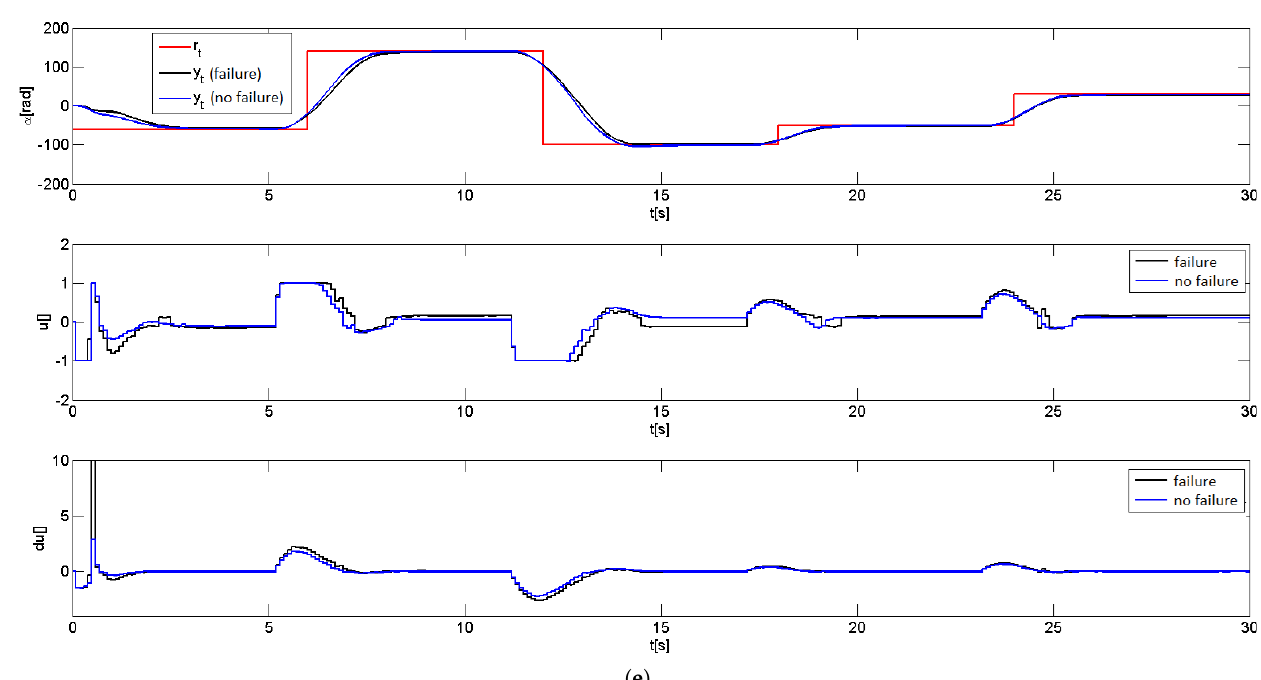
Figure 8. Experimental results concerning actuator failure with q u = 3000, T S = 0.1 s. ( a ) Absolute IAE change; ( b ) Relative IAE change; ( c ) Absolute ISE change; ( d ) Relative ISE change; ( e ) Tracking performance with and without actuator failure, N u = 5, N y =